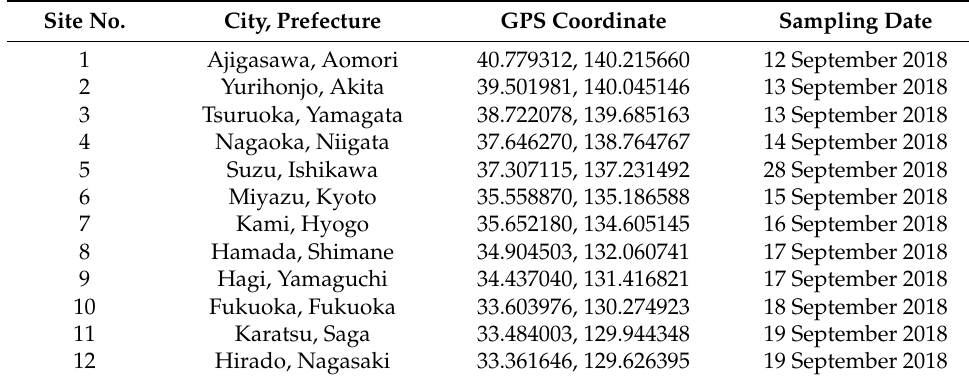
Figure 1. Locations of the 12 sampling sites. Table 1. Site locations and sampling